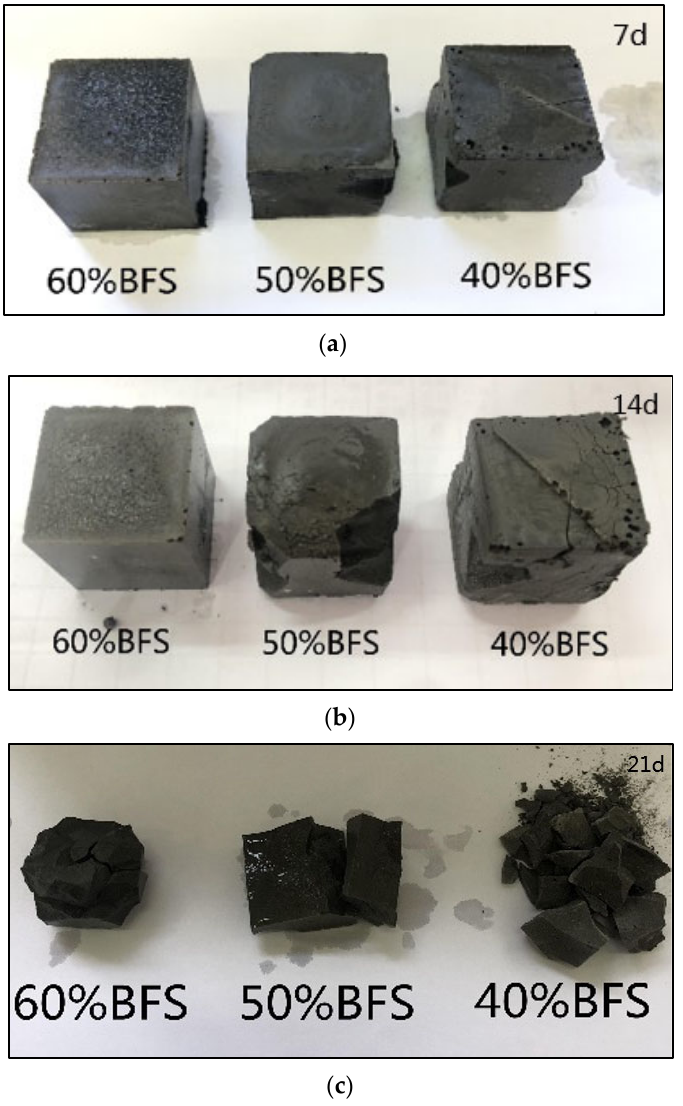
Figure 8. Macro changes in geopolymer prepared with different proportions of BFS overtime under freeze–thaw cycle.